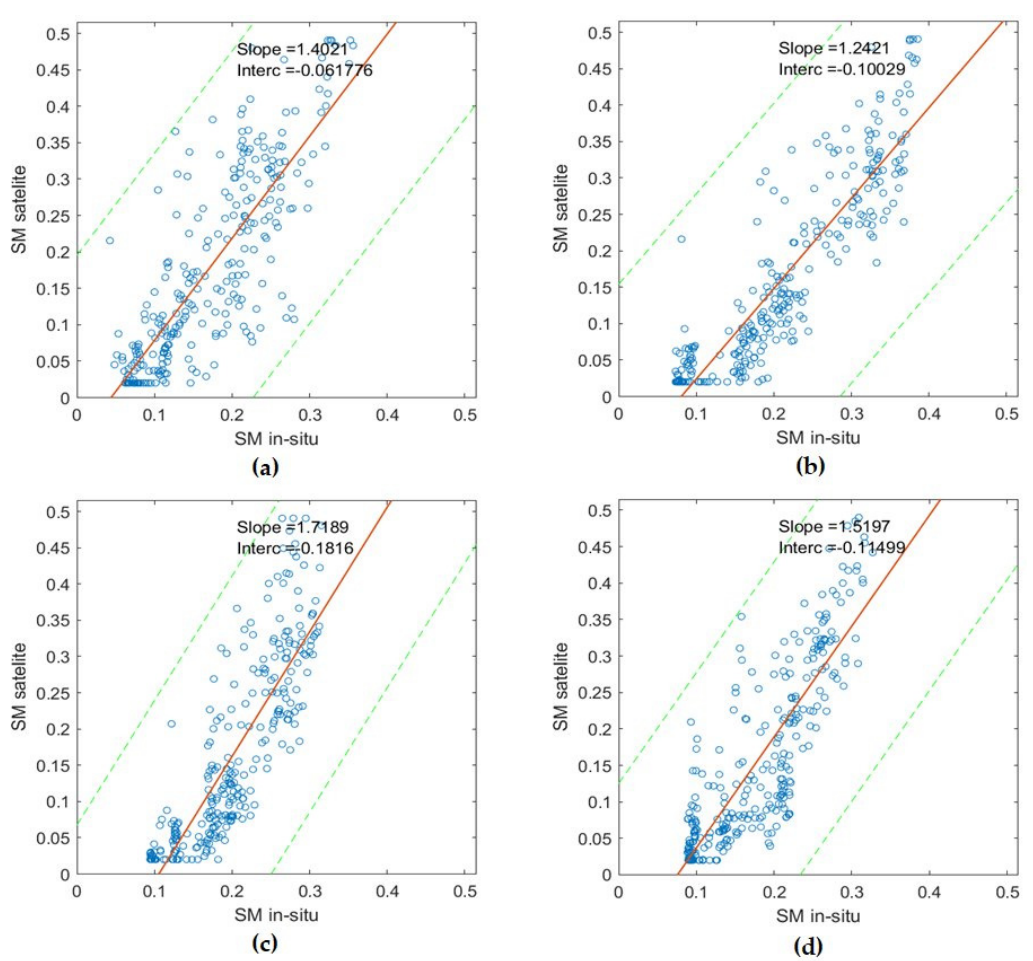
Figure 6. Scatterplots of station-averaged SSM and SPL3SMP_E_9kmSSM: ( a ) Grid_34104, ( b ) Grid_34105, ( c ) Grid_34106, and ( d ) Grid_34107. Green dashed lines represent a confidence level of 95%.